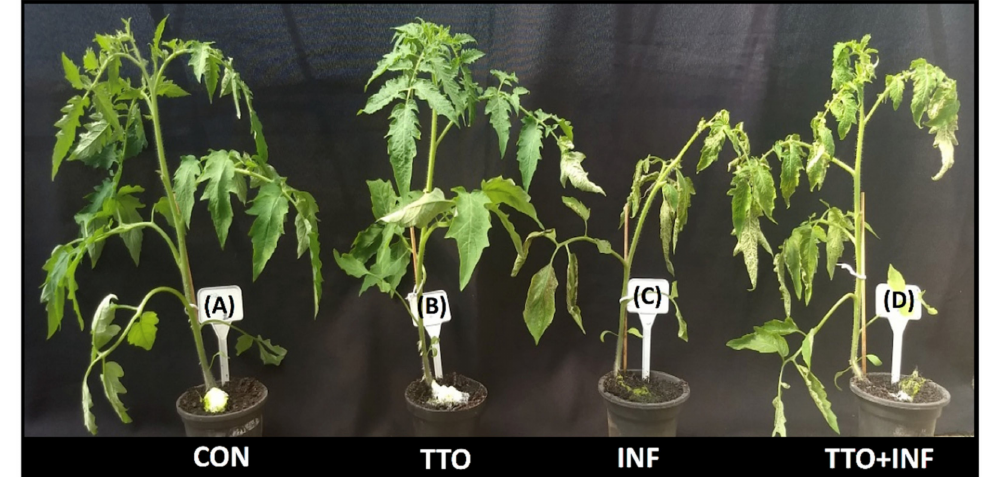
Figure 4. E ff ect of TTO treatment of tomato plants inoculated and non-inoculated with X. campestris. ( A ) control plants (CON); ( B ) TTO-treated plants (TTO); ( C ) X. campestris infected plants (INF); and ( D ) plants treated TTO and infected with X. campestris (TTO +